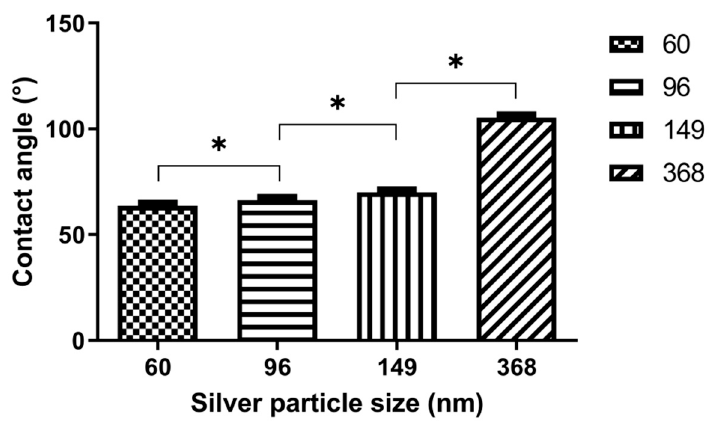
Figure 6. Mean values of water contact angle measurements of the four different silver particle size. (* p < 0.01)